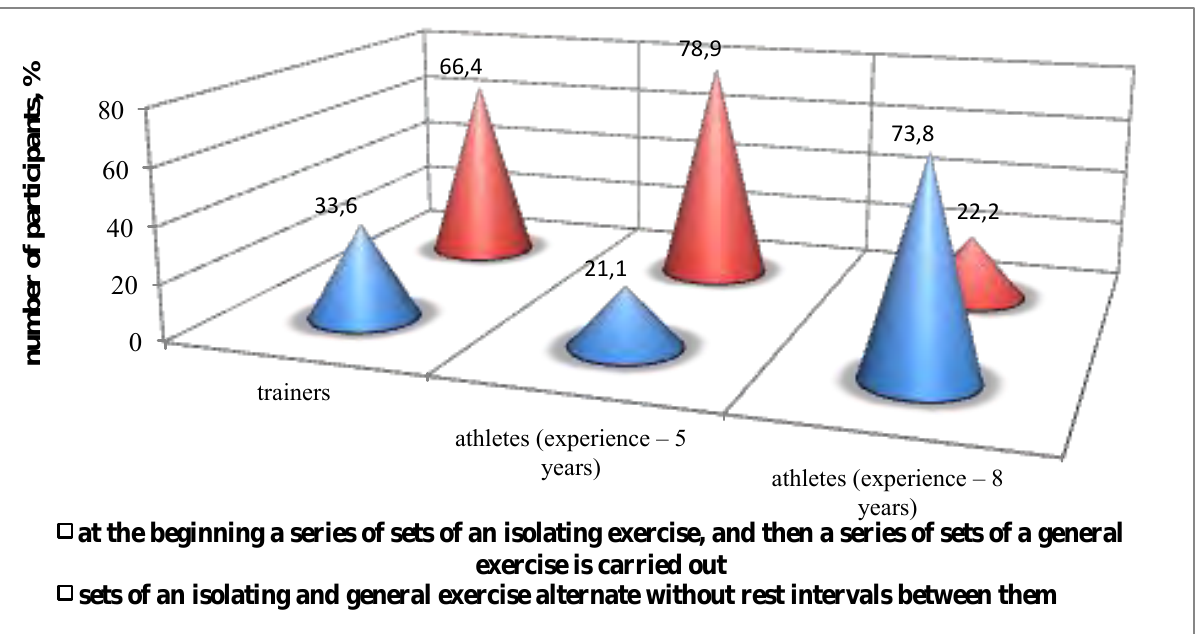
Fig. 4. Types of preliminary exhaustion and the level of its use by trainers and athletes in bodybuilding at the stage of a specialized basic training (according to the survey results) ,